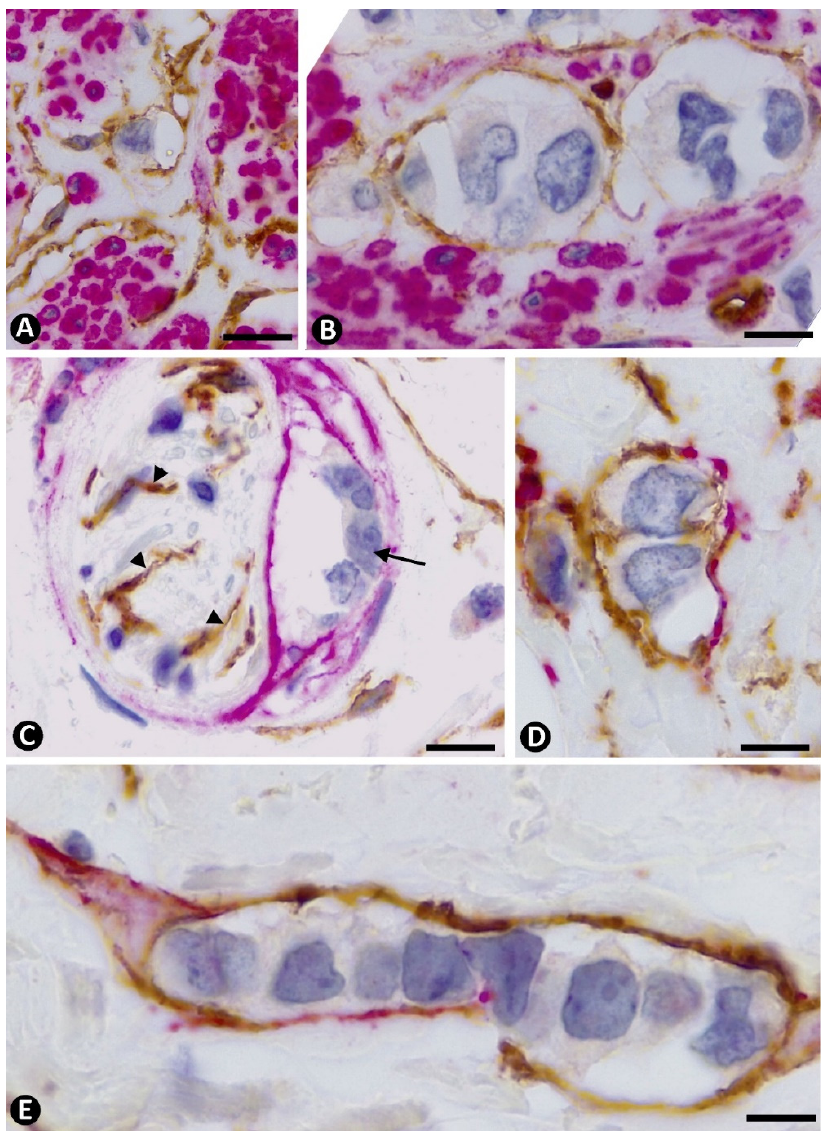
Figure 8. Double immunochemistry labelling for CD34 (brown) and α SMA (red). Haematoxylin counterstain. ( A , B ): CD34+SCs (brown) around neoplastic cells in the smooth muscle fascicles (red) of the breast nipple. ( C ): α SMA+ stromal cells (red) in the epi-perineurium of a small nerve surrounding neoplastic cells (arrow). Note CD34+SCs/TCs (brown, arrowheads) in the endoneurium. ( D , E ): CD34+ (brown) and α SMA+ (red) stromal cells around the same nest ( D ) and strand ( E ) of neoplastic cells. Bar: ( A ): 30 µm; ( B , D ): 10 µm; ( C ) 25 µm; ( E ): 10 µm.